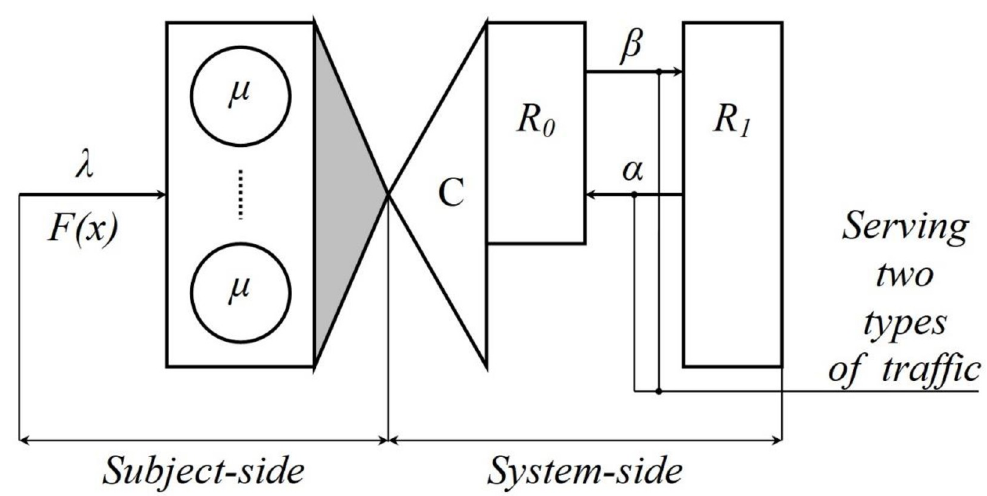
Fig 1. Scheme of the queuing system as a model of a balanced session of subject-system interaction.